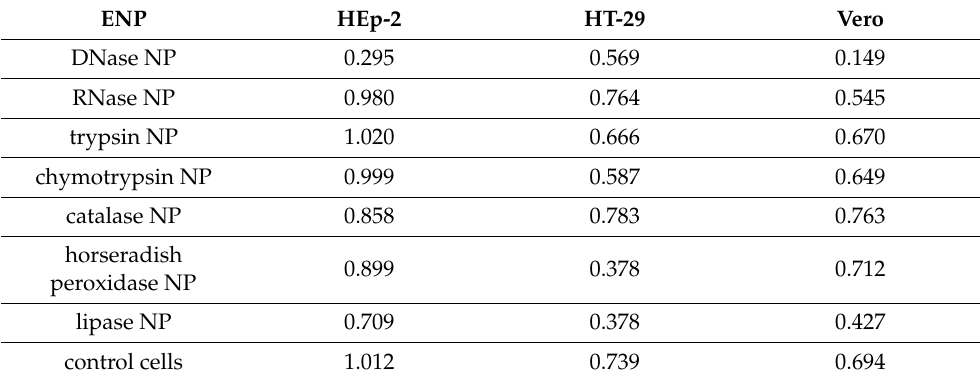
Figure 9. Viability of Vero cells in the presence of 0.1 mg/mL ENP. Optical microscopy images (×400). Table 2. Data of MTT test for HEp-2, HT-29 and Vero cells in the presence of ENP at 3 days posttreat- ment. Absorbance at 570 nm (optical units